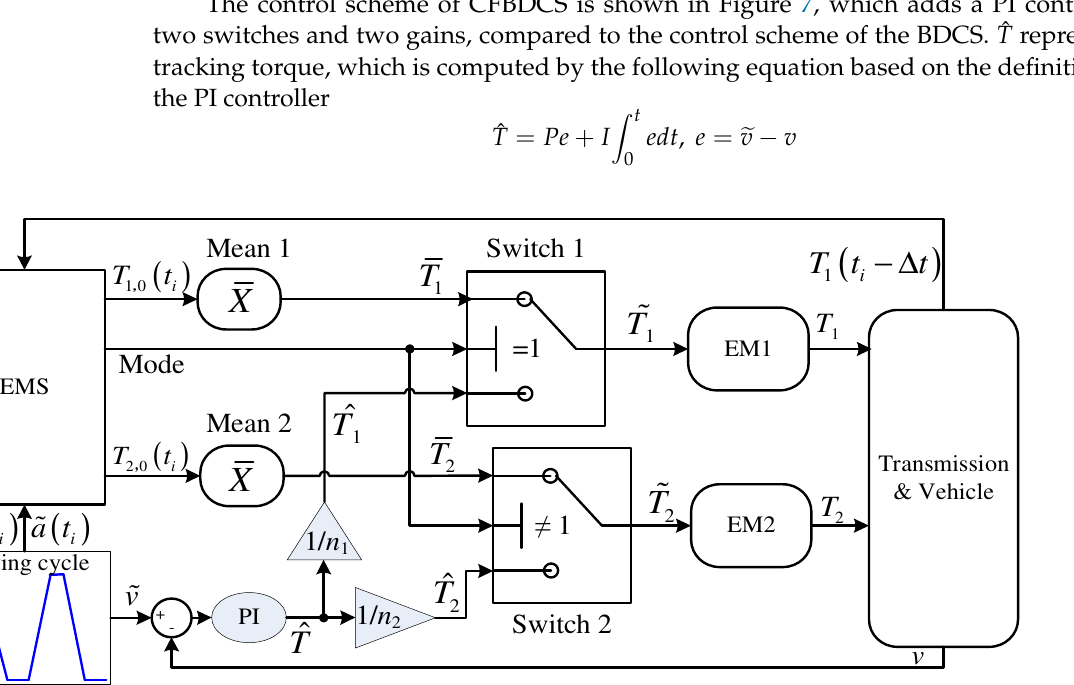
Figure 7. Control scheme of CFBDCS.